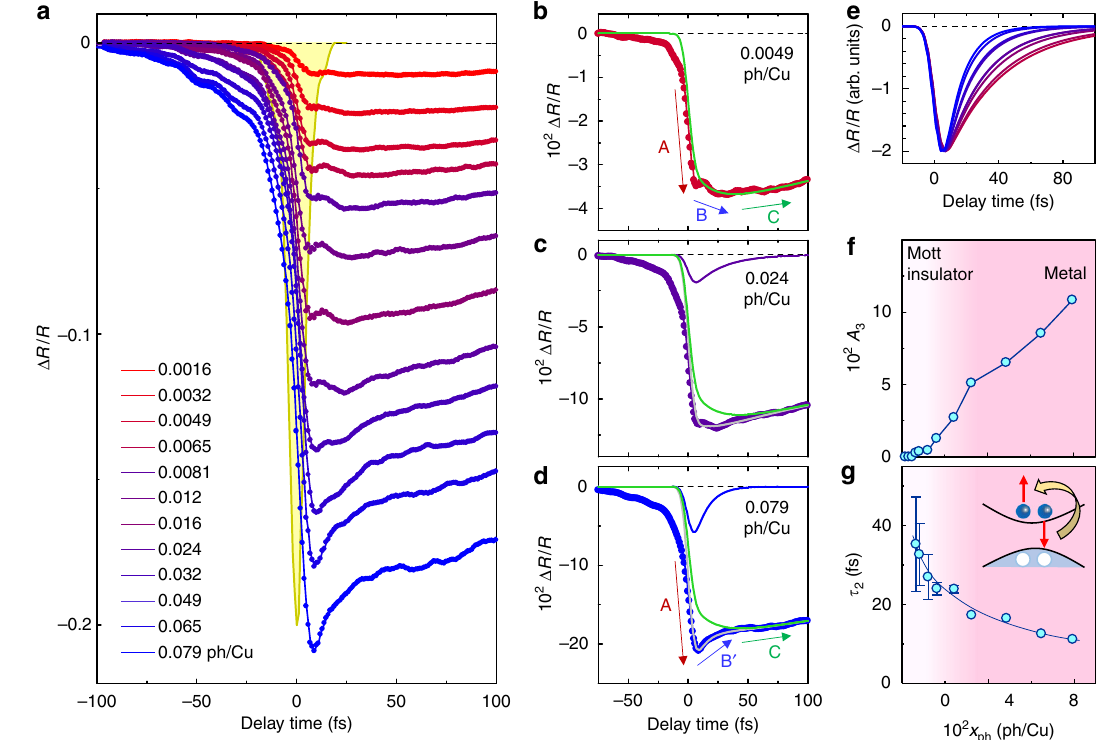
Fig. 3 Results of the pump-probe re fl ection measurements in Nd 2 CuO 4 . a Time evolutions of re fl ectivity changes Δ R / R for x ph = 0.0016 – 0.079 ph/Cu. A yellow line reshows the cross-correlation pro fi le between pump and probe pulses. b – d Time evolutions of Δ R / R for b x ph = 0.0049 ph/Cu, c x ph = 0.024 ph/Cu, and d x ph = 0.079 ph/Cu with fi tting curves. Green and purple lines in ( c ) (green and blue ones in ( d )) re fl ect the mid-gap-absorption components and the Drude components, respectively. Thin gray lines show the sum of two components. e Time evolutions of re fl ectivity changes Δ R / R re fl ecting the Drude components for x ph = 0.0065 – 0.079 ph/Cu derived from the fi tting analyses. The colors are the same as in ( a ). f , g x ph -dependences of f amplitudes and g decay time of the re fl ectivity changes Δ R / R re fl ecting the Drude components. Error bars in ( g ) show standard deviations of the least- squares fi t. The inset shows a schematic illustration of the Auger recombination NATURE COMMUNICATIONS| (2018) 9:3948 |DOI: